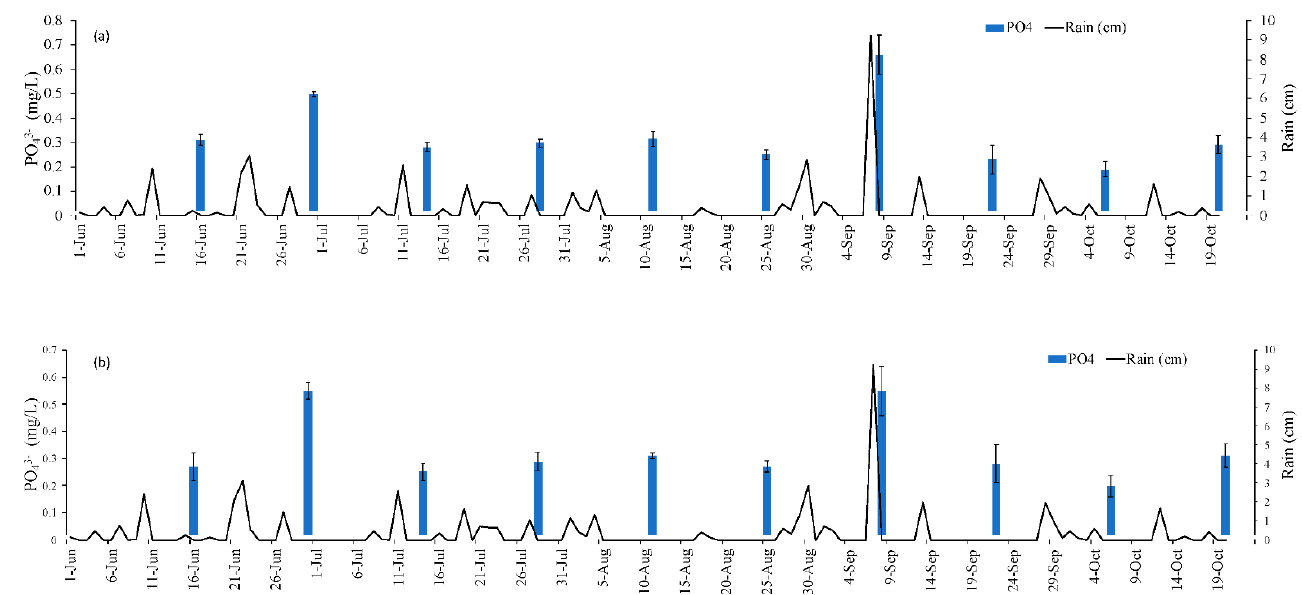
Figure 7. Average PO 43 − concentrations ( a ) 1 m upstream and ( b ) 1 m downstream of treatment gates. Error bars are standard deviation of triplicate samples.